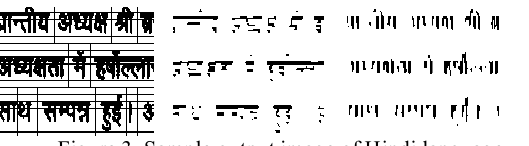
Figure 2. Sample output image of Kannada language.